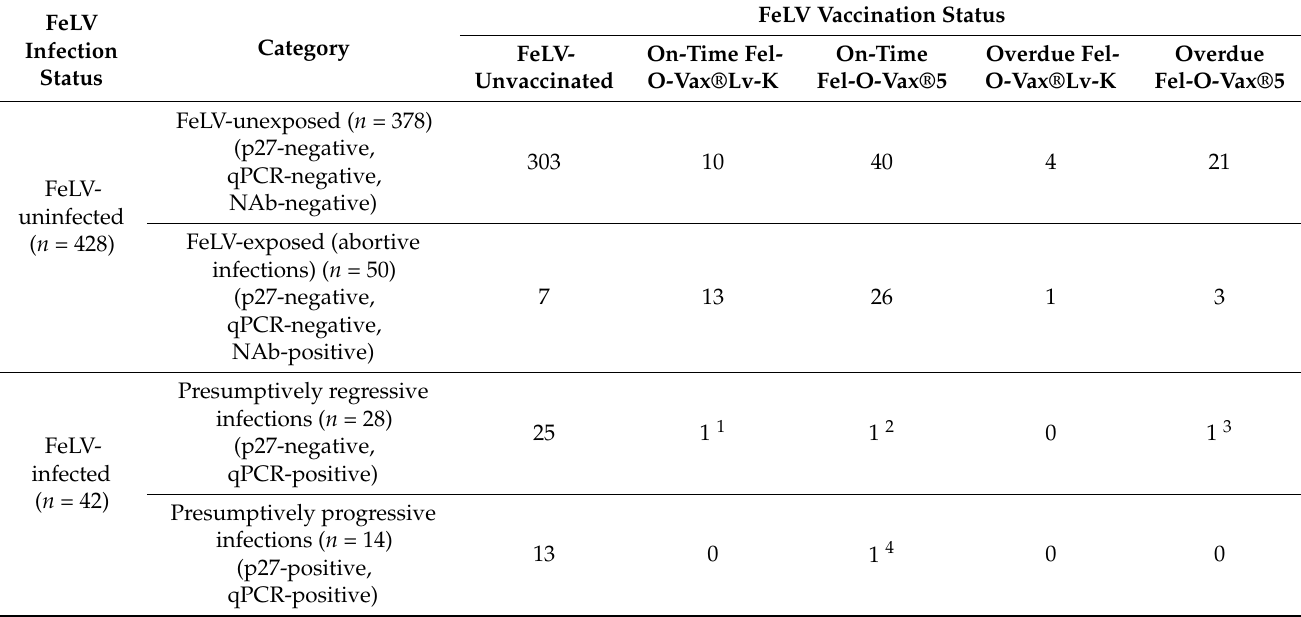
Table 1. Summary of FeLV infection status and FeLV vaccination history of the cats in the current study ( n = 470). On-time vaccination referred to the previous vaccination being given within the past 18 months, while overdue vaccination referred to the last vaccination being given more than 18 months previously. FeLV-uninfected/FeLV-unexposed cats that were overdue for vaccination were excluded from all analyses, while FeLV-uninfected/FeLV-exposed cats (abortive infections) overdue for vaccination were retained. None of the four FeLV-vaccinated/FeLV-infected cats had been tested for FeLV infection prior to